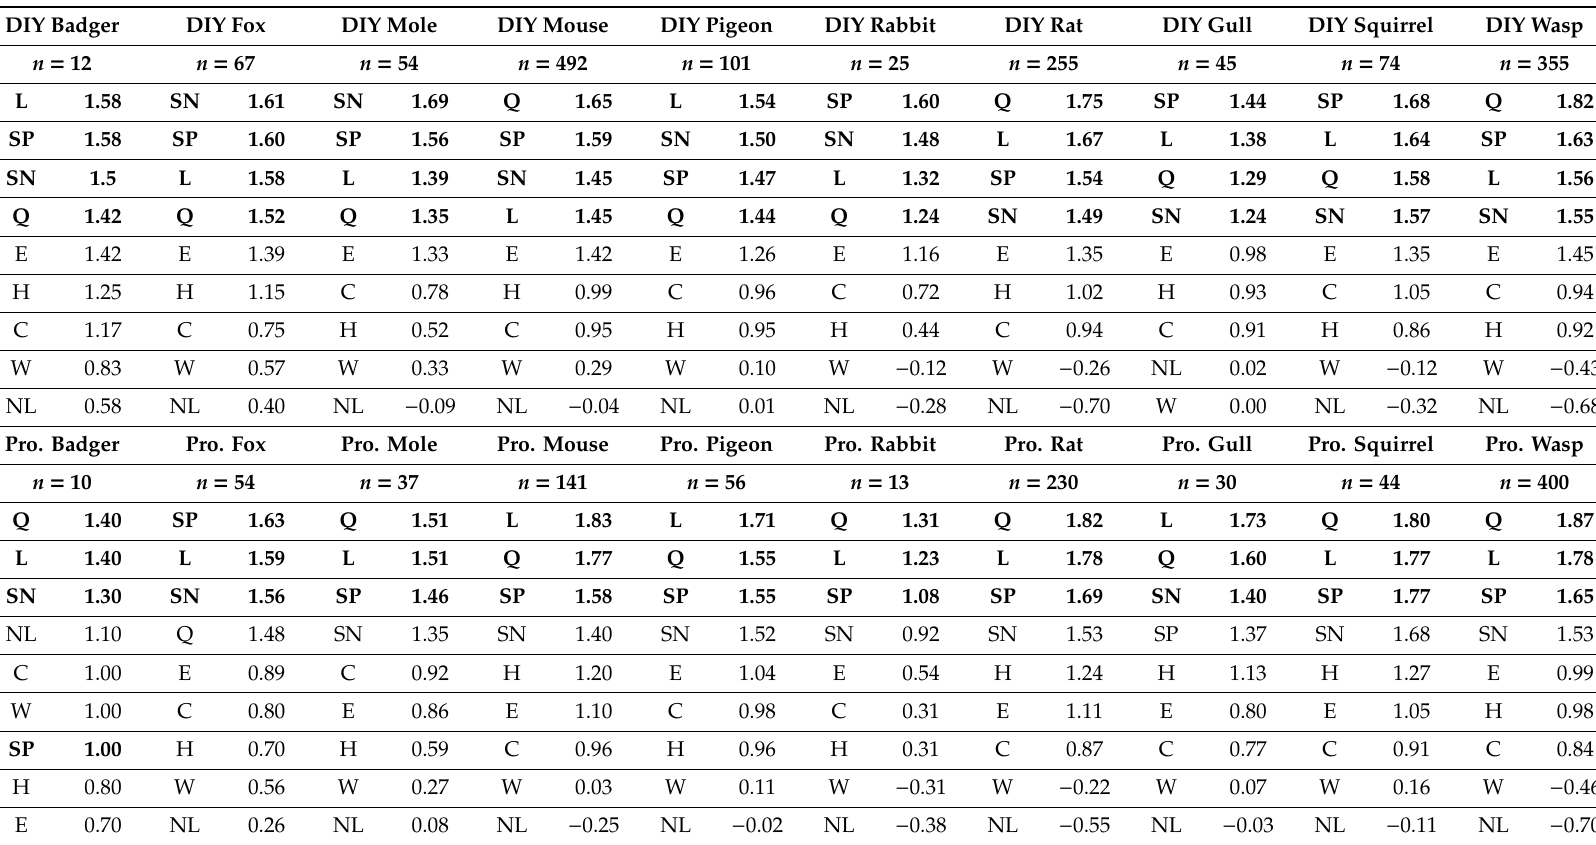
Table 2. Importance ranking of factors in choosing Do-It-Yourself (DIY) and professional (Pro.) control services for 10 species. Scores shown are mean importance scores; positive scores indicate that a factor is considered important and greater scores indicate greater importance. Q = ’Solves problem quickly’, L = ’Long-lasting e ff ect’, C = ’Low cost’, NL = ’Non-lethal (does not involve killing)’, W = ’Welfare-friendly for the target pest, E = ’Easy to use’, H = ’Hygienic (requires me to have minimal contact with dead animal)’, SP = ’Safe for people and pets’, SN = ’Safe for non-target wild animals’. The four most important factors (ranked highest) for each species are shown in